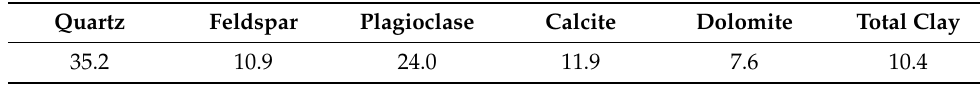
Table 1. X-ray diffraction analysis of the relative quantity.